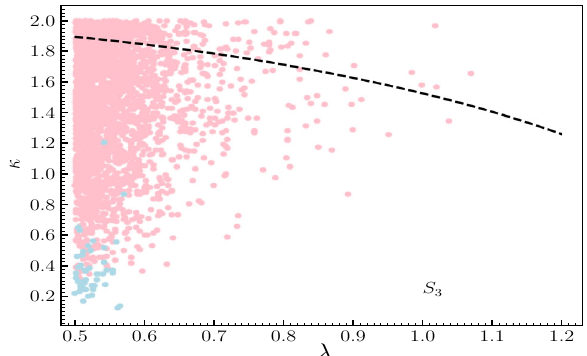
Fig. 12 Viable points of the parameter space for S 3 in the κ − λ plane. The light-red (light-blue) colour represents cases where the SM-like Higgs is (is not) the lightest scalar. All light-red and light-blue points below the black dashed line fulfill the perturbativity condition up to 10 TeV of Eq. (26)